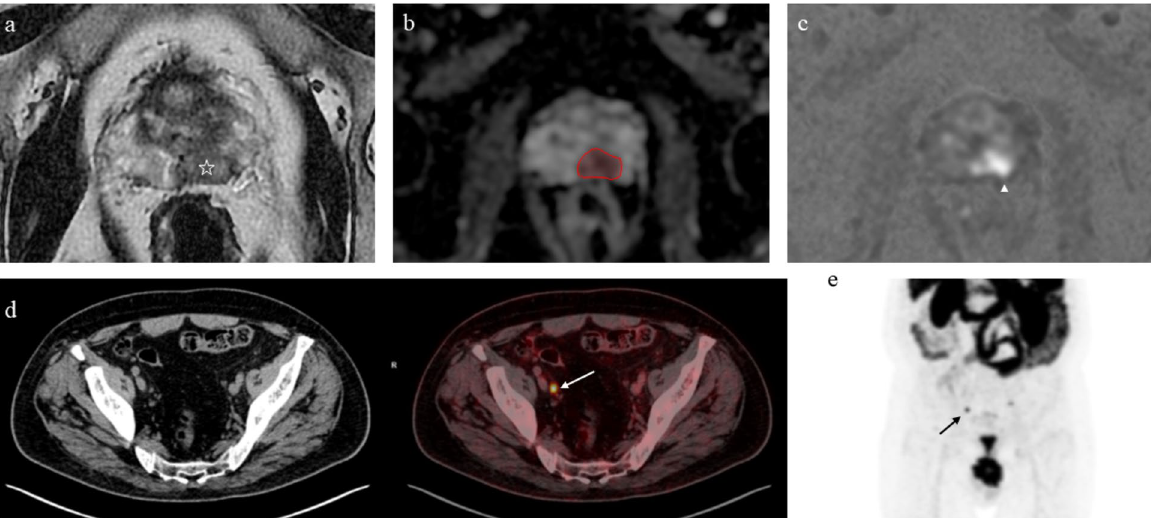
Fig. 4 Seventy-two-year-old patient who underwent radical prostatectomy for prostate cancer (at pathology, Gleason score 3 shows a large peripheral zone (left posteromedial) lesion with intermediate signal on T2-weighted images ( a , lesion epicentre marked with white star), focal and marked hypointensity on the ADC map ( b , red region of interest) and corresponding hyperintensity on high b value DWI ( c , white arrowhead). Three years after treatment, rise of PSA value determines biochemical recurrence. [ 68 Ga]Ga-PSMA-11 PET/CT ( d and e ) shows a small but concerning right external iliac lymph node. ADC Apparent diffusion coefficient, DWI Diffusion-weighted imaging, MRI Magnetic resonance imaging, PET/TC Positron emission tomography/computed tomography, PMSA Prostate-specific membrane antigen, PSA Prostate-specific